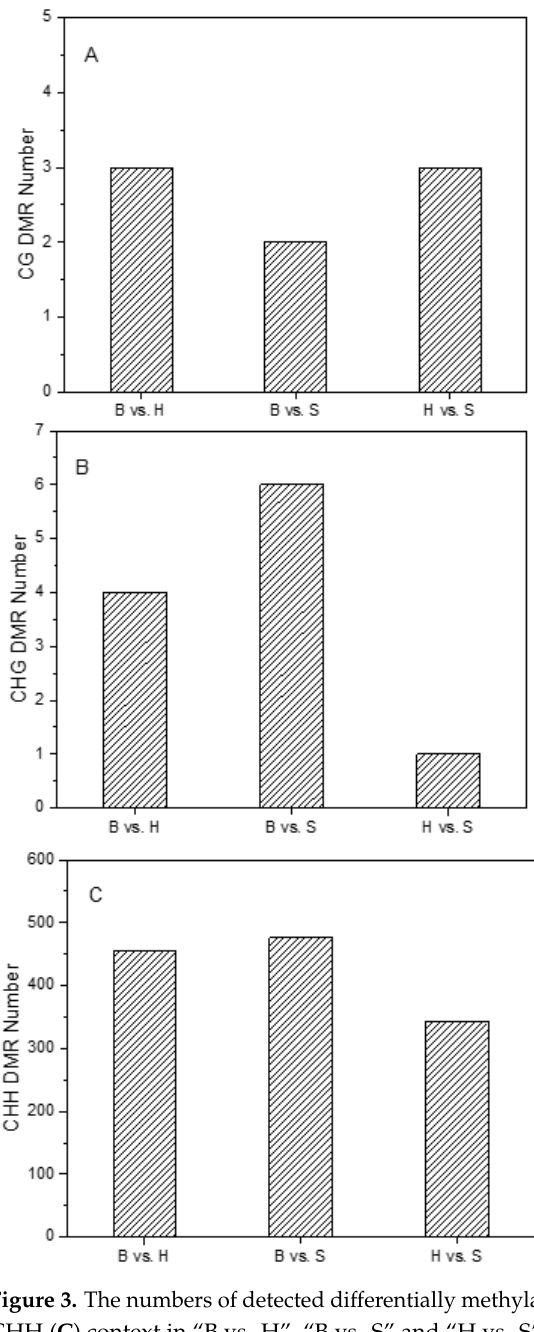
Figure 3. The numbers of detected differentially methylated regions (DMRs) of CG ( A ), CHG ( B ) and CHH ( C ) context in “B vs. H”, “B vs. S” and “H vs. S” groups. B, H and S represented the blade, holdfast and stipe, respectively.